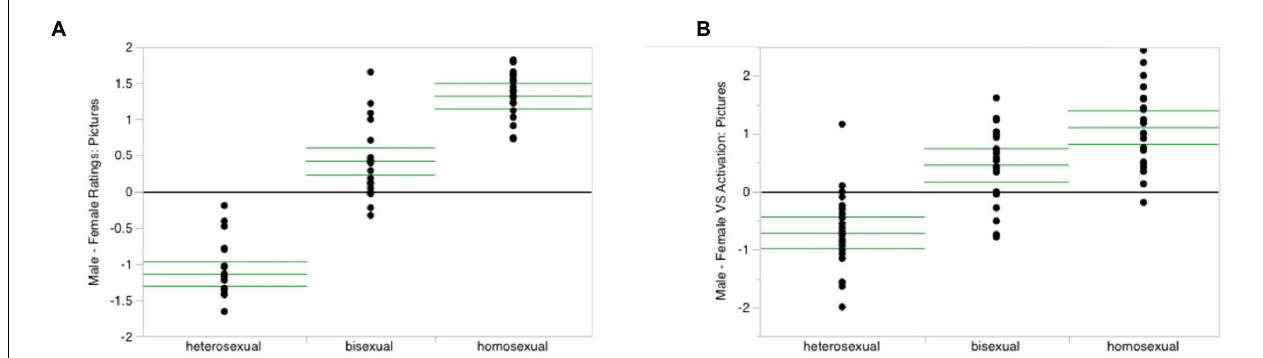
FIGURE 2 | To explain a mismatch between subjective ratings and brain scanning results, I use real data from the study on sexual orientation by Safron et al. (2017). Of course, this by no means suggests that any such orientation is a mental disorder; that case has been settled a long time ago (Zachar and Kendler, 2012). On the left (A) you can see the results for male subjects’ own ratings of how much they liked erotic pictures featuring men or women: the higher the score, the more they preferred the former over the latter. Subjects had been split into a hetero-, bi-, and homosexual group according to a questionnaire on sexual preferences. Note that there is no overlap between the heterosexual and homosexual groups. On the right (B) you can see the corresponding data from the ventral striatum, a brain area frequently associated with erotic experiences. Note that while these data resemble the results from the subjects’ own ratings, there is now some overlap between the heterosexual and homosexual groups; in particular, there is one outlier on top of the “heterosexual” column who identified himself as heterosexual (questionnaire) and stated that he liked female erotic pictures more than those of men (ratings shown in (A) ), but whose brain activation falls right into the middle of that of the homosexual group. If we ascribed psychological constructs on the basis of such measurements, this example illustrates substantial implications for people’s mental autonomy and personal identity. License: Creative Commons Attribution 4.0 International License